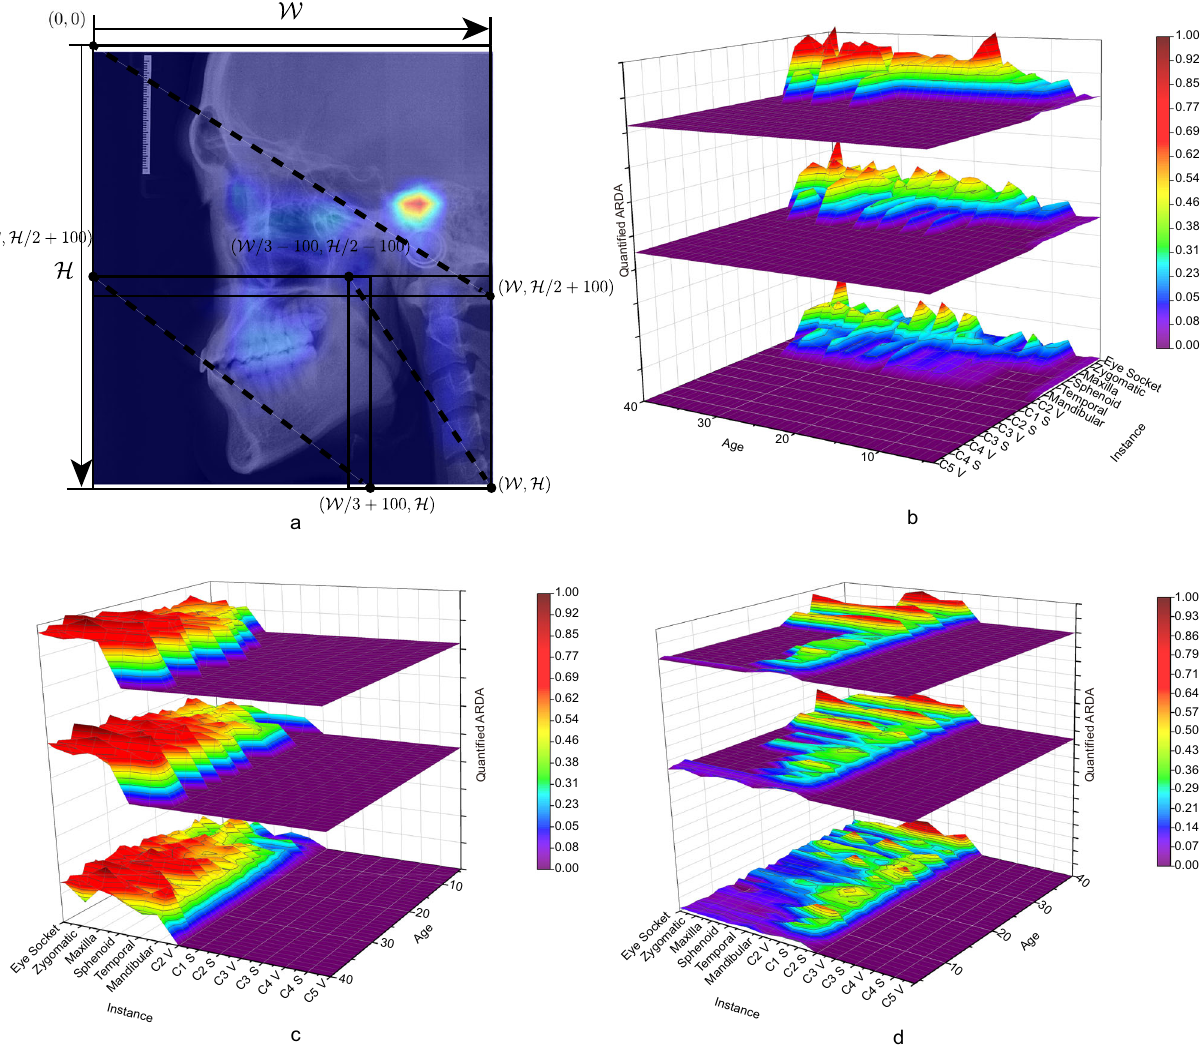
Fig. 6 Illustration of quanti fi ed ARDA in ARDA concentrated regions. a The position of the teeth, craniofacial and cervical spine regions in the LCR images. The coordinates of the upper left and lower right corners of each region are speci fi ed. The coordinate system is established with the upper left corner of the LCR images as the origin, the positive direction of the x axis to the right, and the positive direction of the y axis to the down. b , c , d are the quanti fi ed ARDA of each instance of the teeth, craniofacial, and cervical spine regions, respectively. In b , c , d the three surface plots from bottom to top are the cases in which the ageing-signi fi cant region threshold is set to the median, 75-th, and 90-th percentile of average ageing salience, respectively. Source data are provided as a Source Data fi